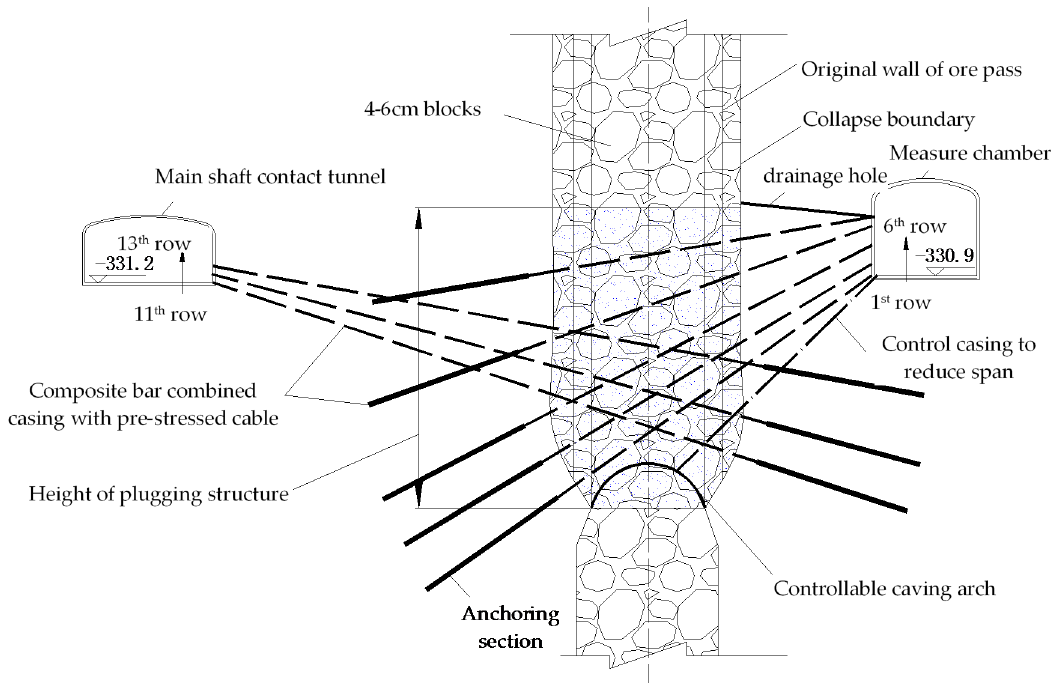
Figure 12. Plugging design of the main ore pass.